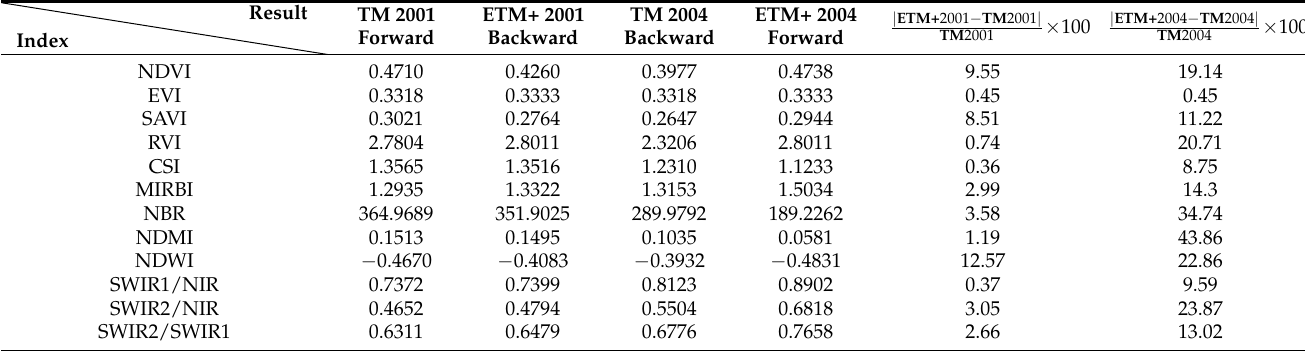
Table 5. Results of index and relative difference (%) based on mean reflectance of sample points from the overlapped TM/ETM+ images from 2001 and